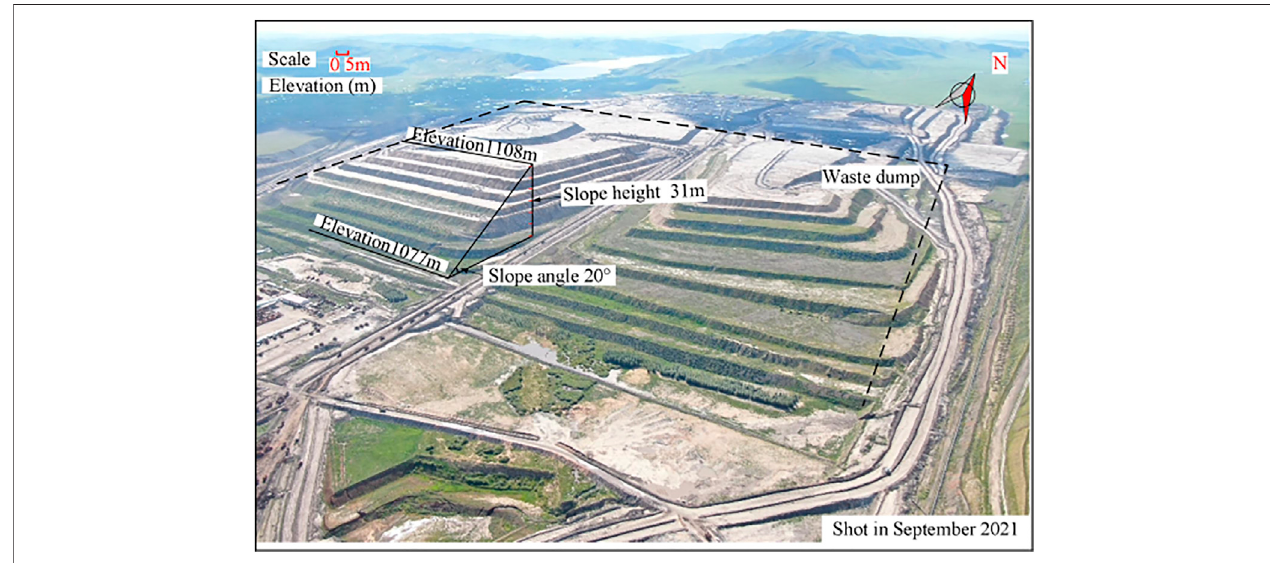
FIGURE 7 | Schematic diagram of external waste dump.